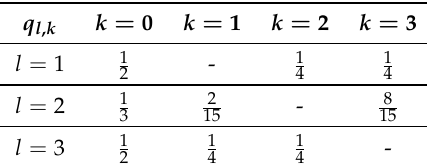
Table 1. Transition probabilities q l , k